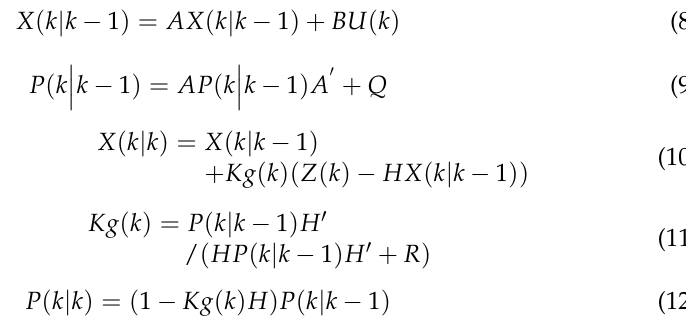
Figure 5. Processing of IgG antibody signals by modulus maximum method.